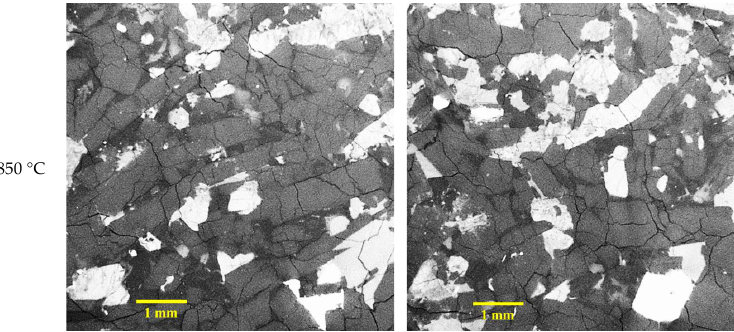
Figure 8. CT images of high temperature treated norite, XY plane (parallel to ground surface).